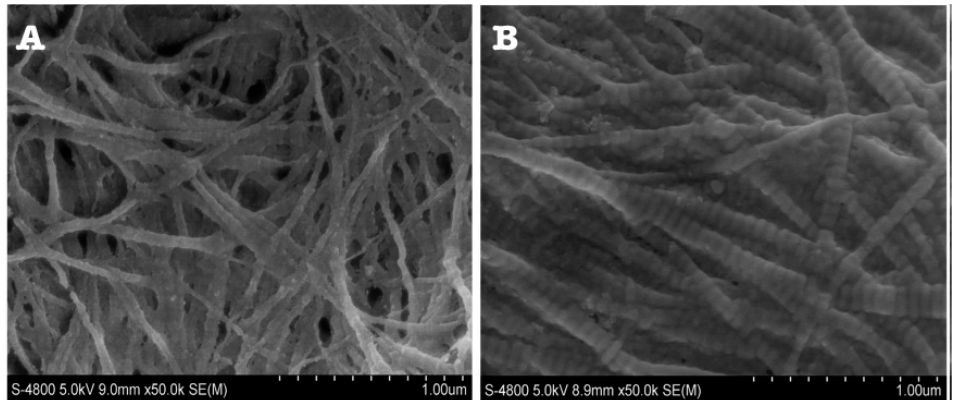
Figure 14. SEM of collagen fibres. Normal and intact fibres with normal banding periodicity in control dentin ( A ). DI dentin collagen fibres have variable and wide banding periodicity ( B ) [33].